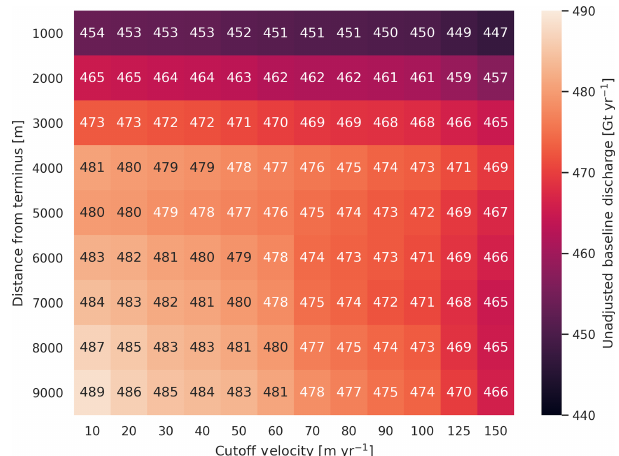
Figure 2. Heatmap and table showing ice sheet discharge as a func- tion of gate buffer distance and ice speed cutoff. The colors of the numbers change for readability.